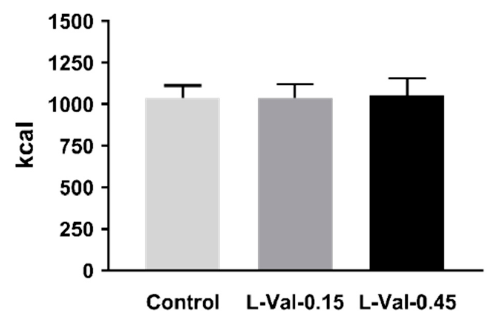
Figure 1. Energy intake from a buffet meal after 90-min intraduodenal infusions of control, or L-valine at 0.15 kcal/min (“L-Val-0.15”) or 0.45 kcal/min (“L-Val-0.45”). One-way ANOVA was used to analyse the data. Statistical significance was accepted at p < 0.05. Data are means ± SEMs, n = 12. Nutrients 2019 , 11 , x FOR PEER REVIEW